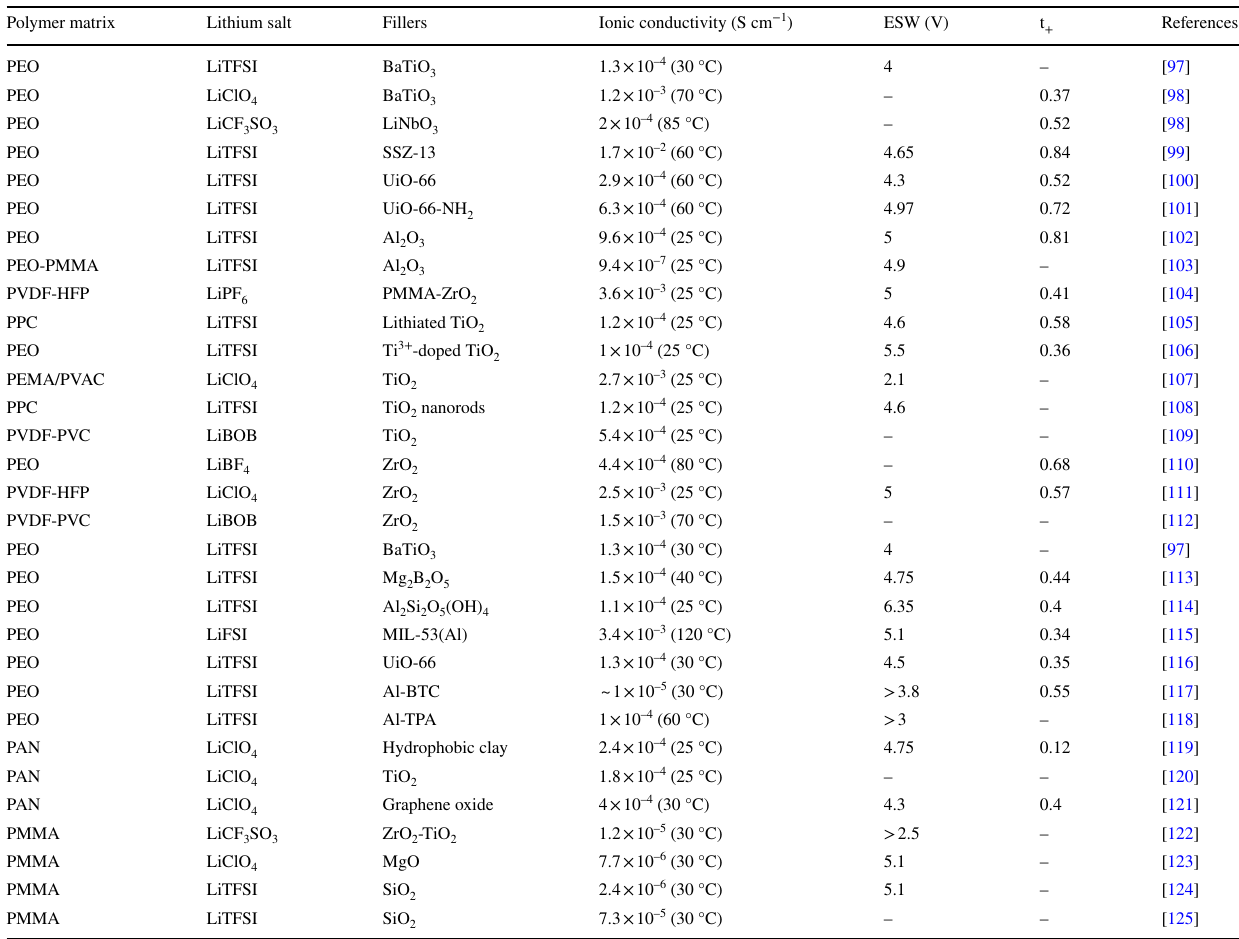
Table 2 PIEs filled with passive fillers and their properties Polymer